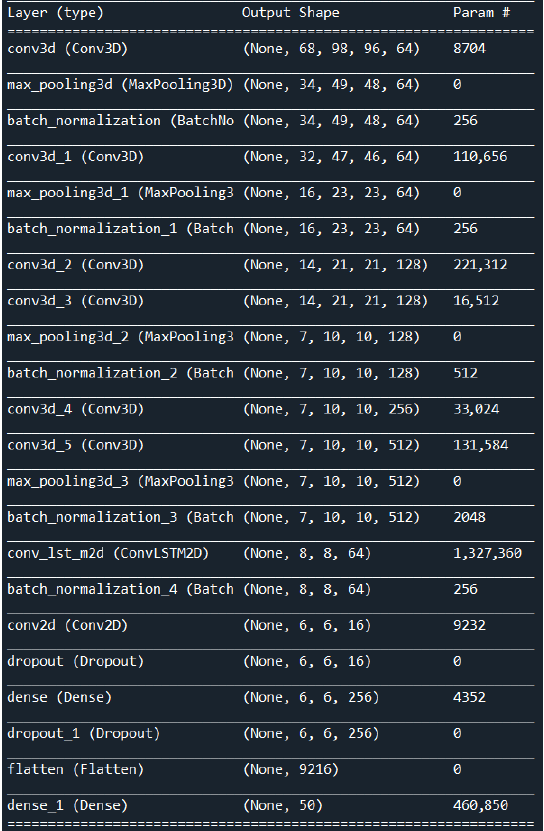
Figure 5. Description of the layers our proposed architecture.